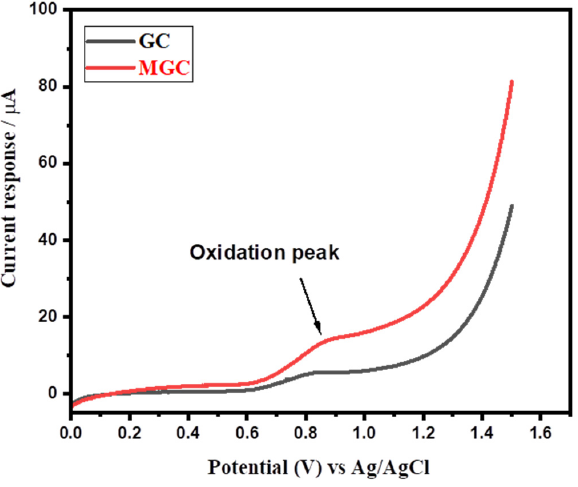
Figure 5. LSV responses of the GC and MGC for 50 µM RS at a scan rate of 50 mV/s.